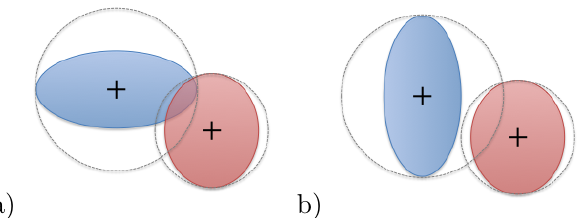
Fig. 2. Illustration of (a) an ICESat overlapping footprint (OFP) pair and (b) near-neighboring